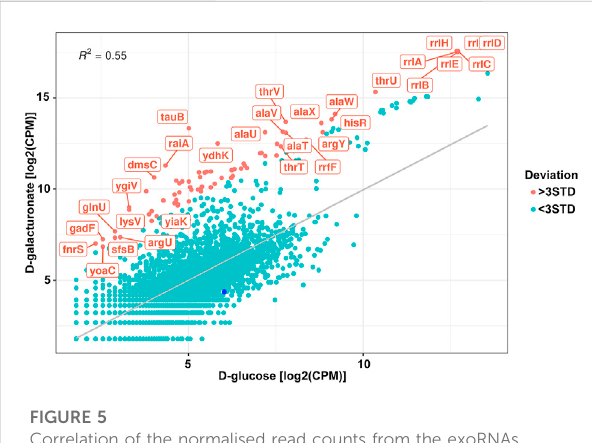
FIGURE 4 Expression dynamics of fl iA and fl gK upon deletion of uxuR and complementationwithcandidateregulatoryRNAs.1 μ molofarti fi cially synthesised RNAs were added to 10 mL of bacterial cultures. Strains are indicated above. Standard deviations were calculated based on three biological replicates, with four technical replicates in each.